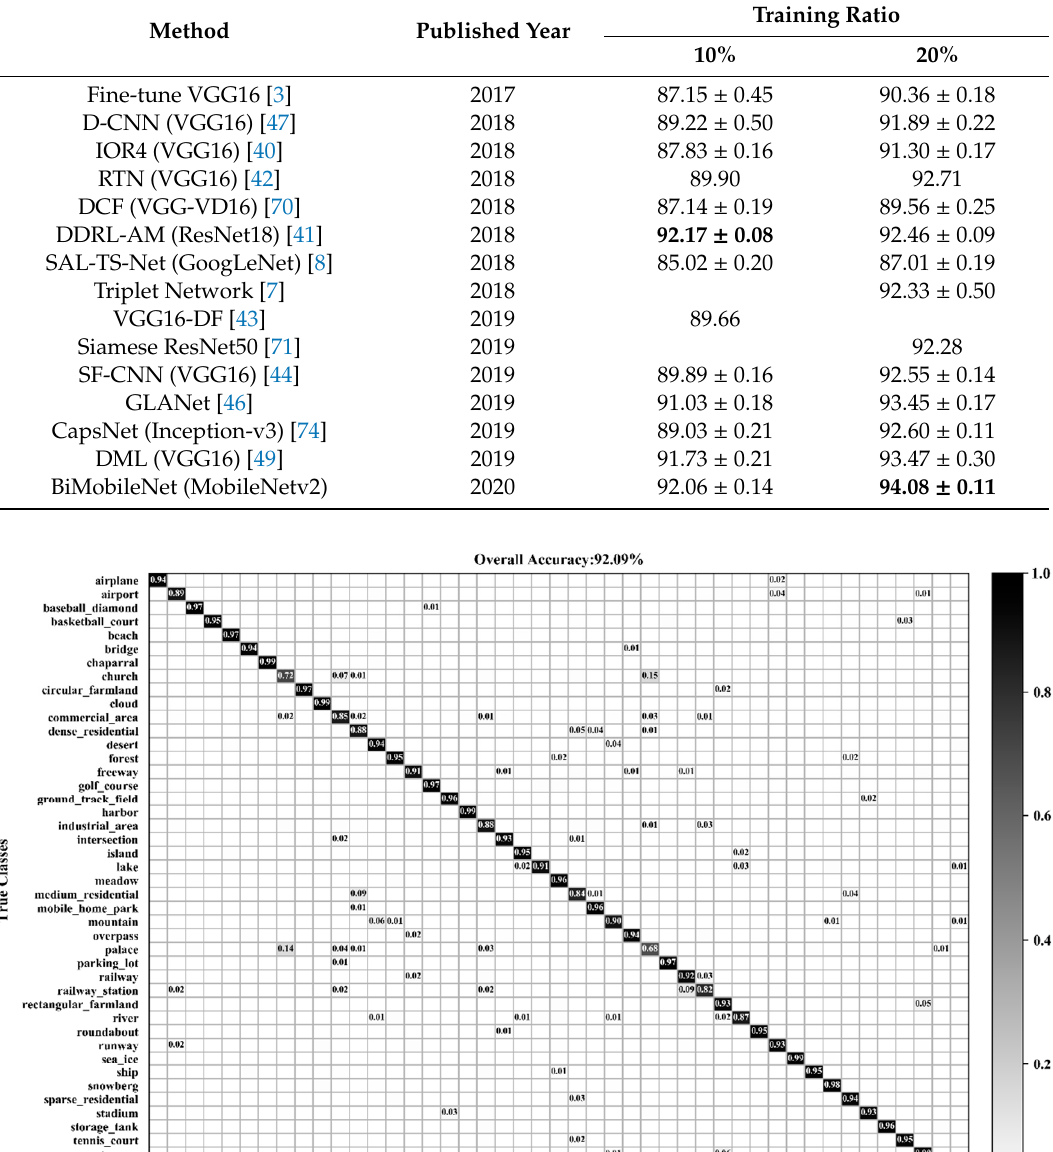
Table 6. Overall accuracy of the state-of-the-art methods on NWPU-RESISC45 dataset. The highest accuracy for each ratio is bolded.